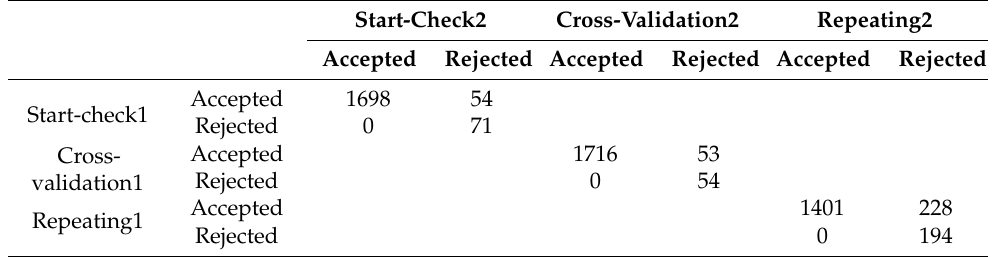
Table 5. QA mechanism variant